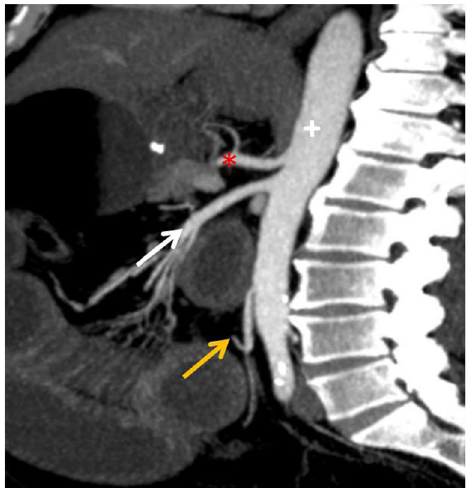
Fig. 1 Anatomy. Sagittal CT MIP (maximum intensity projection) image shows three major arteries that supply the bowel, coeliac trunk (asterisk), superior mesenteric artery (white arrow) and inferior mesenteric artery (orange arrow), which are visceral branches of the abdominal aorta